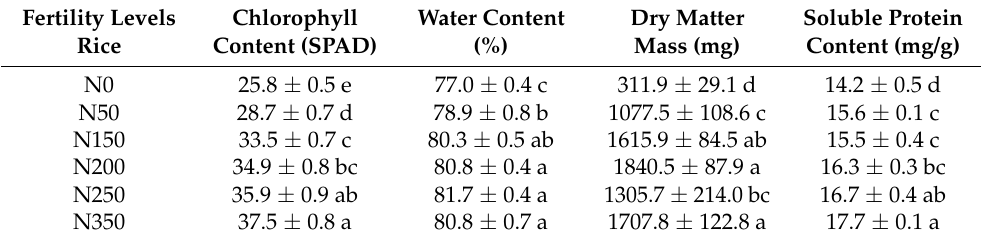
Table 6. Responses of rice physiological parameters to nitrogen fertilizer application.